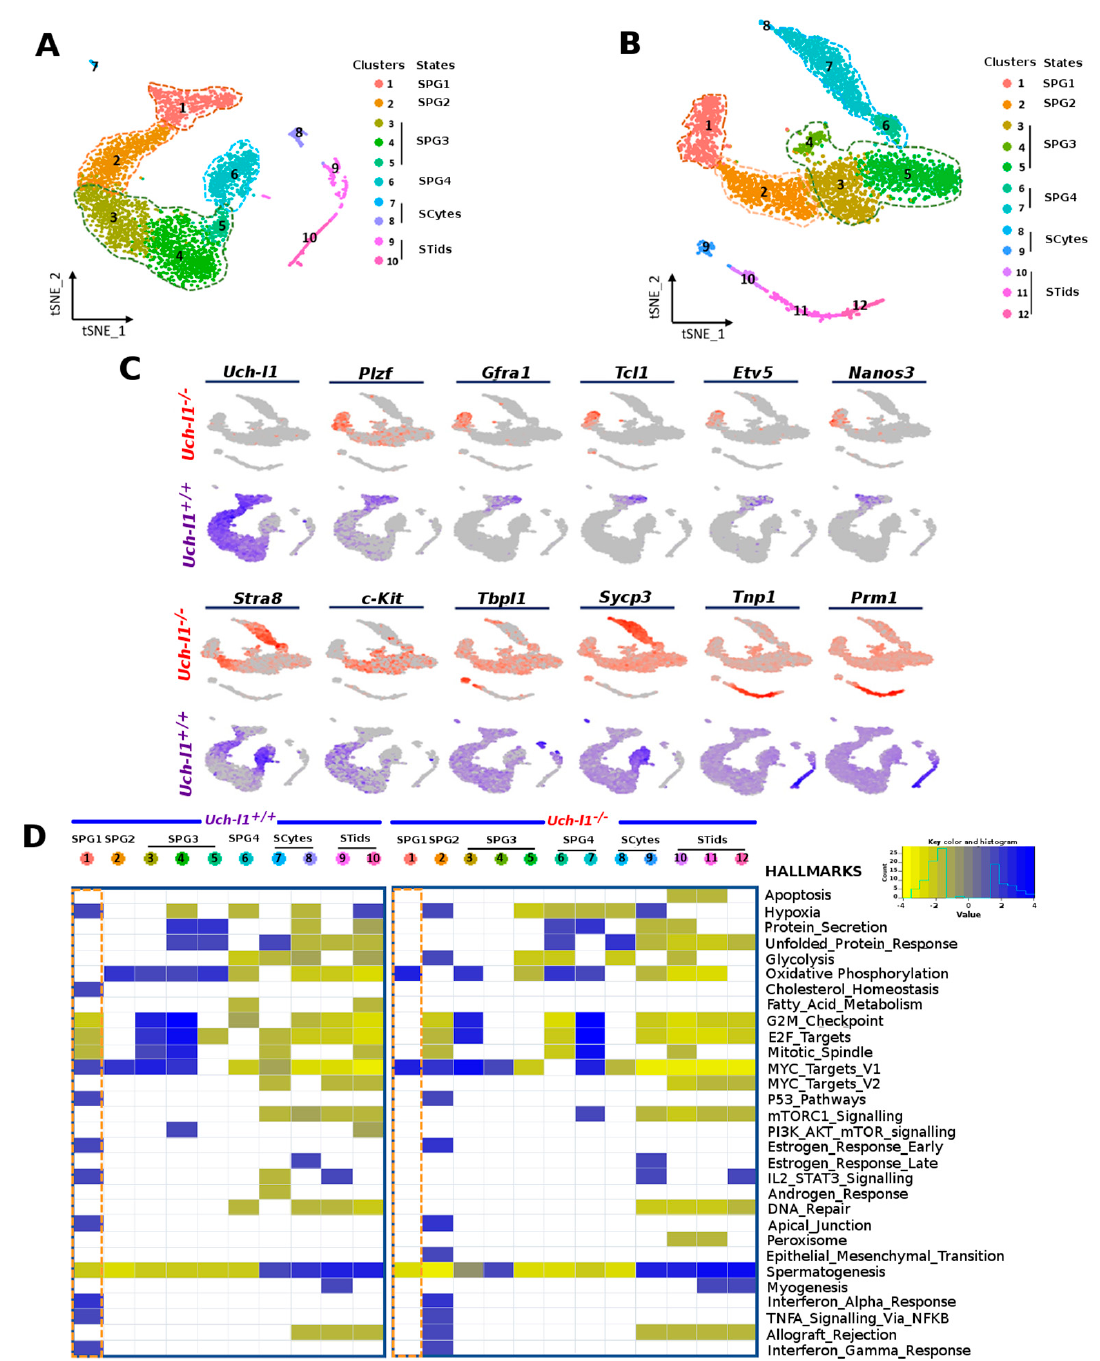
Figure 4. Single-cell RNA sequencing analysis of Uch-l1 +/+ and Uch-l1 − / − spermatogonia. t-SNE analysis plot of single transcriptomes of Uch-l1 +/+ ( A ) and Uch-l1 − / − ( B ), showing unbiased cell clusters distinguished by color according to the key. ( C ) The feature plot shows the expression of some genes that allow the distinction between spermatogonia, spermatocytes and spermatids. ( D ) Heatmaps of the upregulated and downregulated gene sets signatures determined by GSEA in Uchl1 +/+ and Uch-l1 − / − .